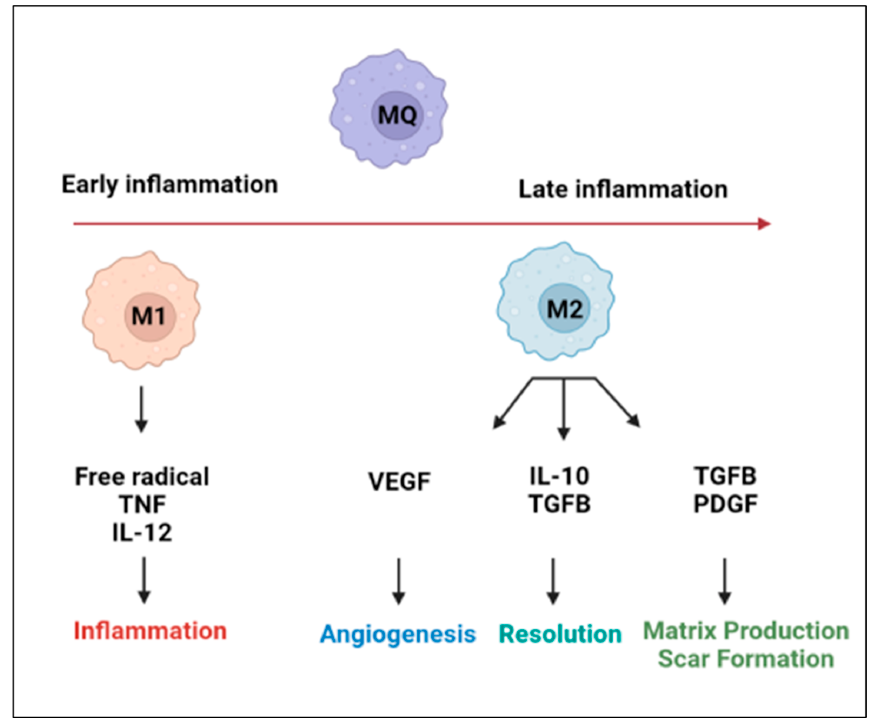
Figure 1. Schematic illustrating the inflammatory signaling mechanisms and the regulation of macrophages during early and late phases of inflammation. M1 macrophages are highly phagocytic and produce large amounts of pro-inflammatory mediators, whereas M2 macrophages produce large amounts of anti-inflammatory mediators and support angiogenesis and tissue